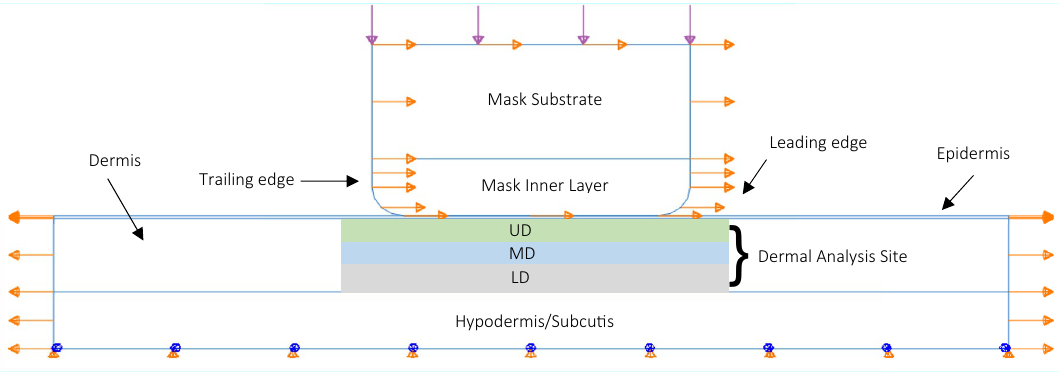
Figure 5. Schematic diagram detailing the compression and translation of a mask model against a skin model, in order to simulate PPE- Skin